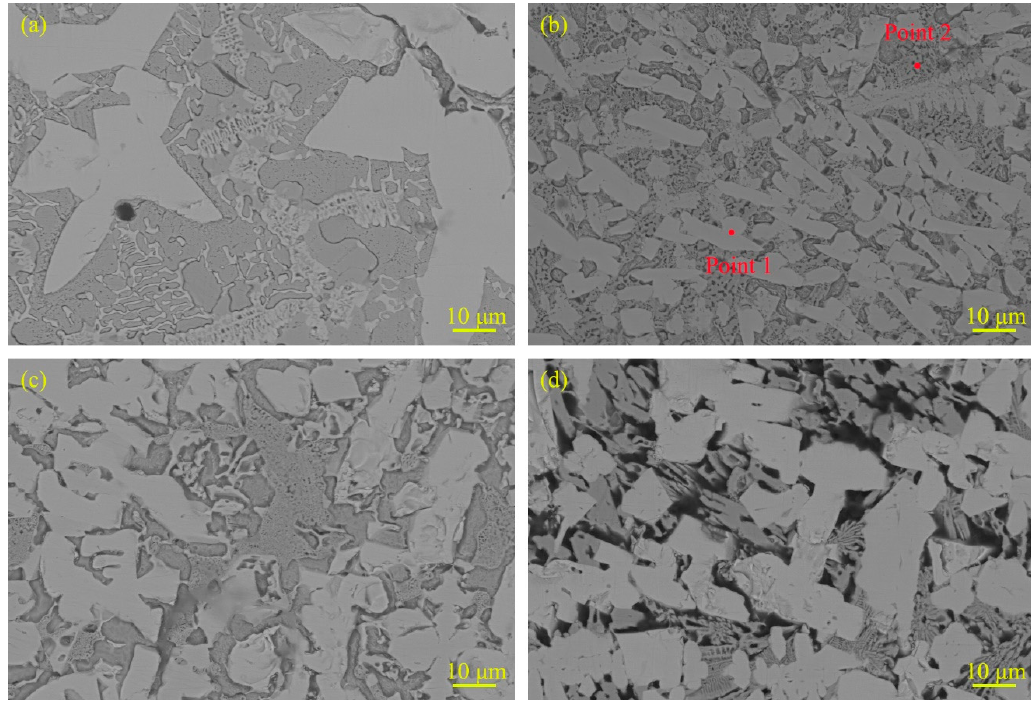
Figure 3. Microstructural morphology of claddings with di ff erent RE contents. ( a ) RE = 0%; ( b ) RE = 2%; ( c ) RE = 4% and ( d ) RE = 8%. Table 4. Composition of hard-phase and eutectic structure of cladding with 2% RE content. Element Mass Percentage (wt.%) Position Structure Mo Fe Cr B Point 1 Hard phase 56.27 14.01 25.44 Point 2 Eutectic structure 10.77